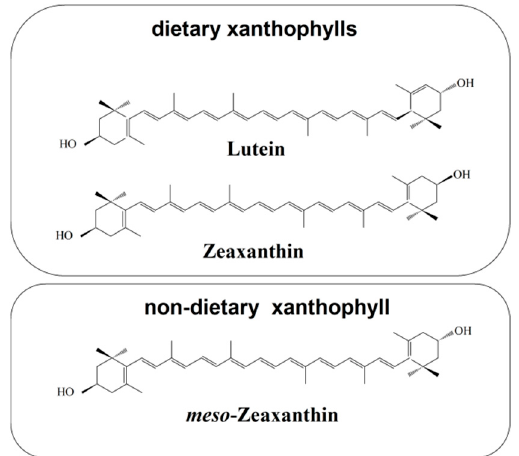
Figure 1. Chemical structures of macular xanthophylls present in the retina, including dietary xanthophylls (lutein and zeaxanthin) and non-dietary xanthophyll (meso-zeaxanthin). Retinal meso-zeaxanthin is a product of the conversion of lutein. This xanthophyll is rarely encountered in the human diet. However, meso-zeaxanthin may be absorbed after oral administration and transported to the retina [11].